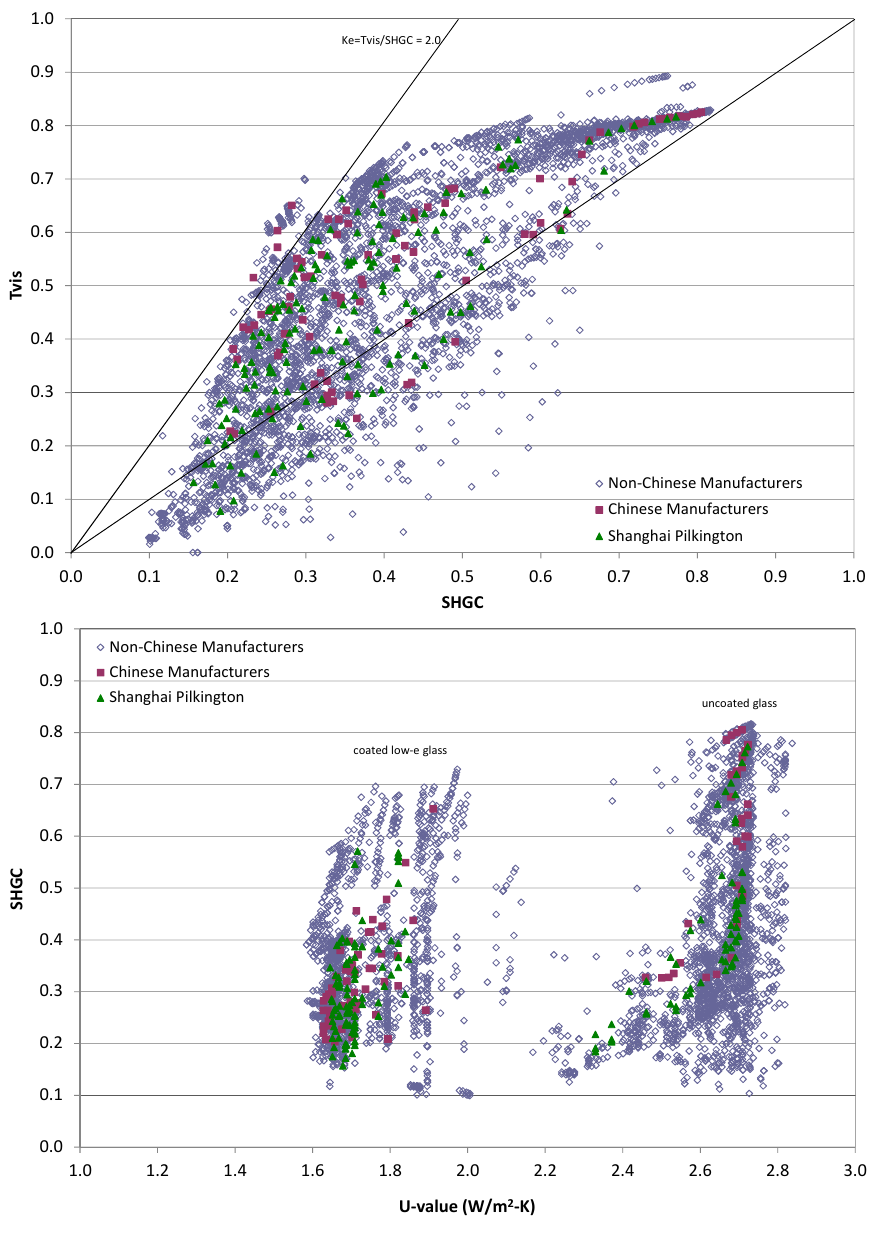
Figure 1. Center-of-glass solar heat gain coefficient, U -value, and visible transmittance (Tvis) data for all glass layers in the IGDB (version 23) combined with a clear 3 mm inboard lite and a 12.7 mm air gap. Lines depict a Ke ratio (Tvis/SHGC) of 2.0 and